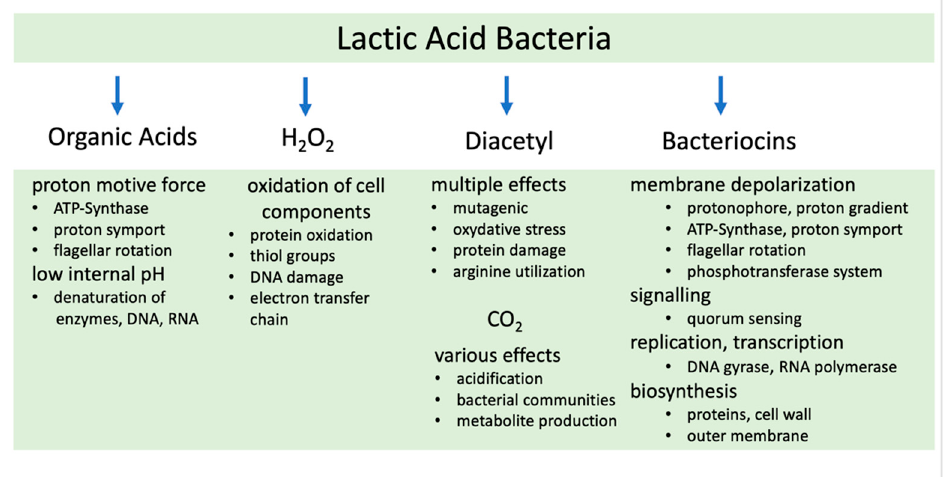
Figure 1. Mode of antibacterial actions by LAB protective cultures. Shown are the major molecules that exert antibacterial activity and the identified targets.